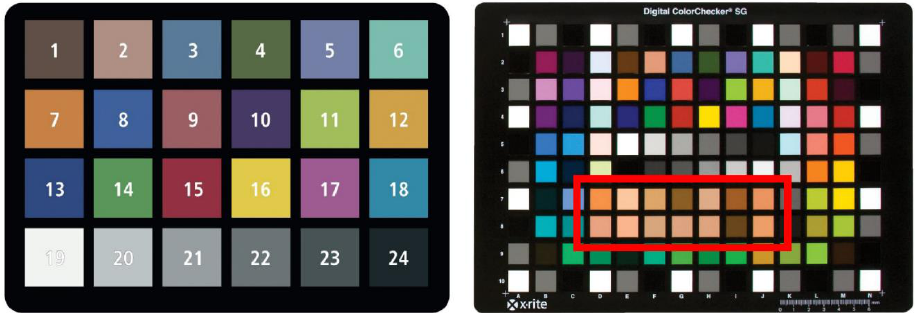
Figure 2. ColorChecker Classic (left, full-range CCT) and Digital SG (right, skin-range CCT). Skin Figure2. ColorCheckerClassic(left, full-rangeCCT)andDigitalSG(right, skin-rangeCCT).Skinpatches patches used in our study are placed inside the red square. used in our study are placed inside the red